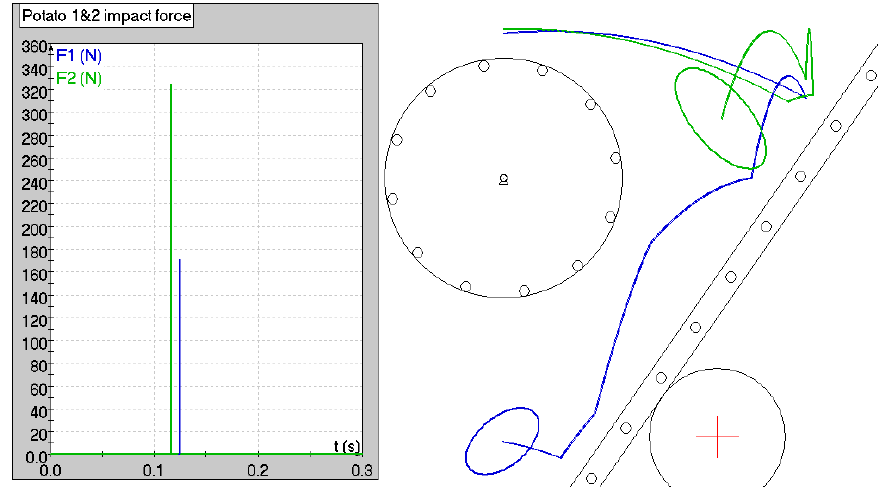
Figure 8. Working Model 2D simulation of the impact of two potatoes of two different sizes with the moving conveyor of the potato–plastic-film separation device.